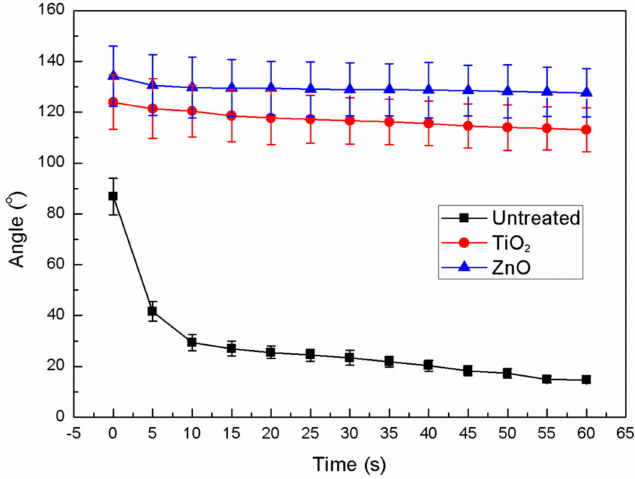
Figure 6. Curve of water contact angle of wood